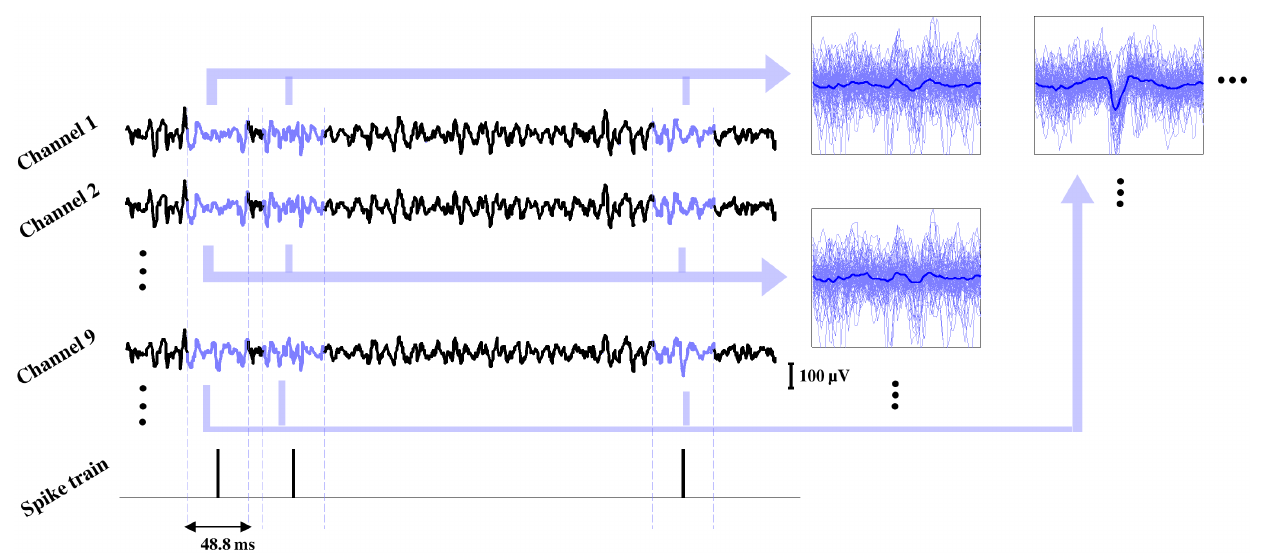
Fig 2. Spike triggered averaging based on the decomposed spike trains. The average waveform around the spiking instants are calculated and organized in an 8 by 8 structure for further processing.